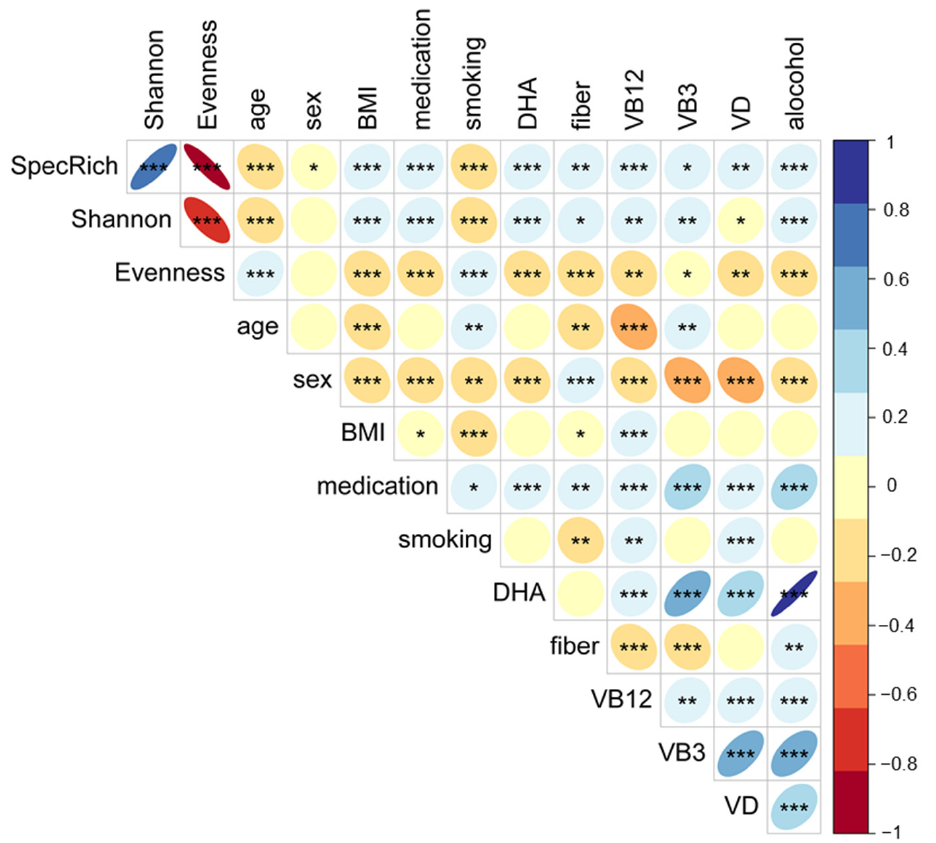
Figure 2. Spearman correlations between alpha diversity indices, phenotype, health and nutrition data of all subjects (* p < 5 × 10 − 2 , ** p <1 × 10 − 2 and *** p < 1 × 10 − 3 ). Continuous variables: species richness (SpecRich), evenness, Shannon index (Shannon), age (in years), BMI (in kg/m 2 ), fiber (g/day), docosahexaenoic acid (DHA, g/day), vitamin B12 (VB12, μ g/day), vitamin B3 (VB3, mg/day), vitamin D (VD, μ g/day) and alcohol (as percentage of energy) and categorial variables: medi- cation (intake: no (2)/yes (1)) and smoking habits (never (1), <3month (2), former (3) and current (4)) and sex (men (1)/women (2)).